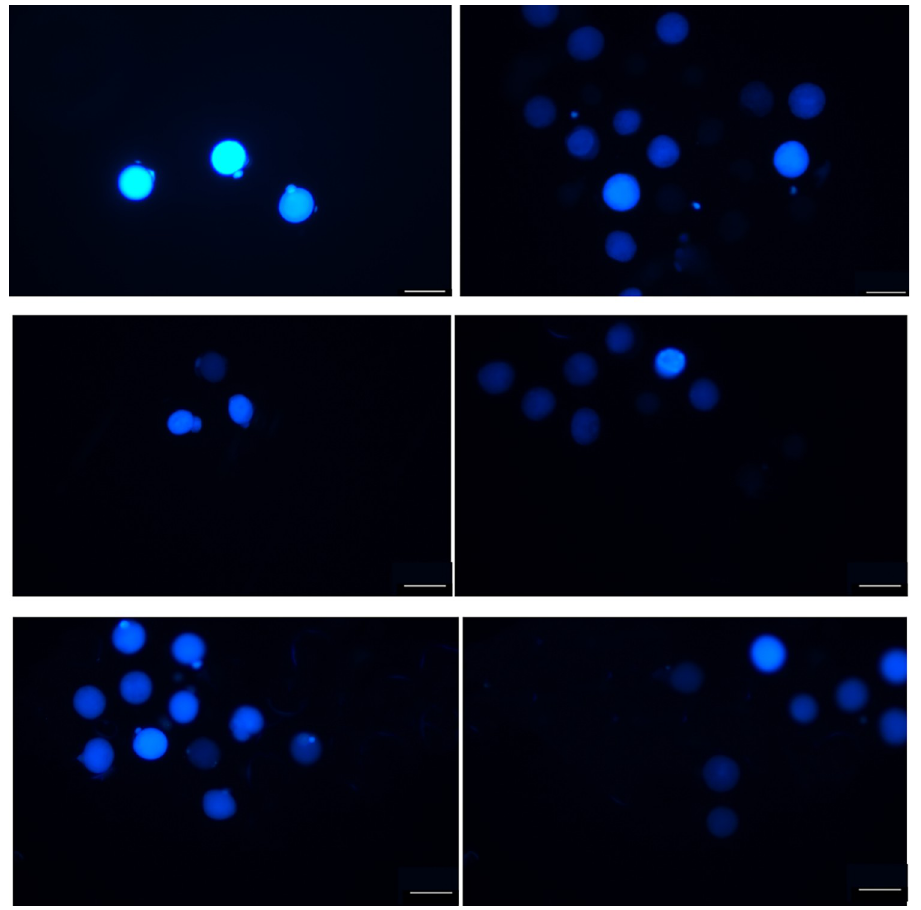
Fig 3. The microtubule morphology of MII oocytes from guinea pigs was divided into two types. For MII oocytes with normal spindles and aggregated chromosomes (A, B and C in the top panel), the chromosomes were distributed and aggregated on the equatorial plate, while for MII oocytes with abnormal spindles and dispersed chromosomes (D, E and F in the bottom panel), the chromosomes could not be neatly distributed on the equatorial plate and are in a diffusion state. A and D are for Hoechst 33342 staining, B and E are for β -tubulin staining, and C and F are merged for A and B, and D and E, respectively. Bar in 50 μ m.